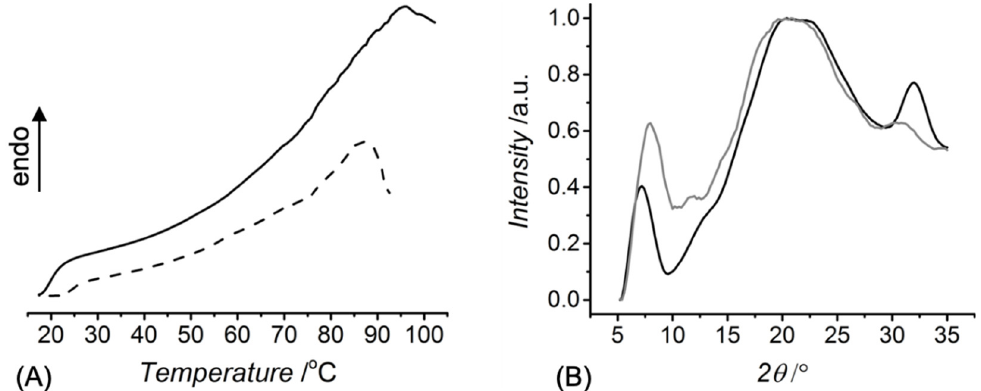
Figure 3. ( A ): DSC thermograms of hydrogels 4VBC-MA* prepared with either 0.4 ( – ∙ – ) or 0.8 wt.-% ( — ) concentration of the sequentially-functionalised CRT precursor. ( B ): Typical WAXS spectra of the dry collagen network 4VBC-MA* ( — ) and native CRT control ( — ).